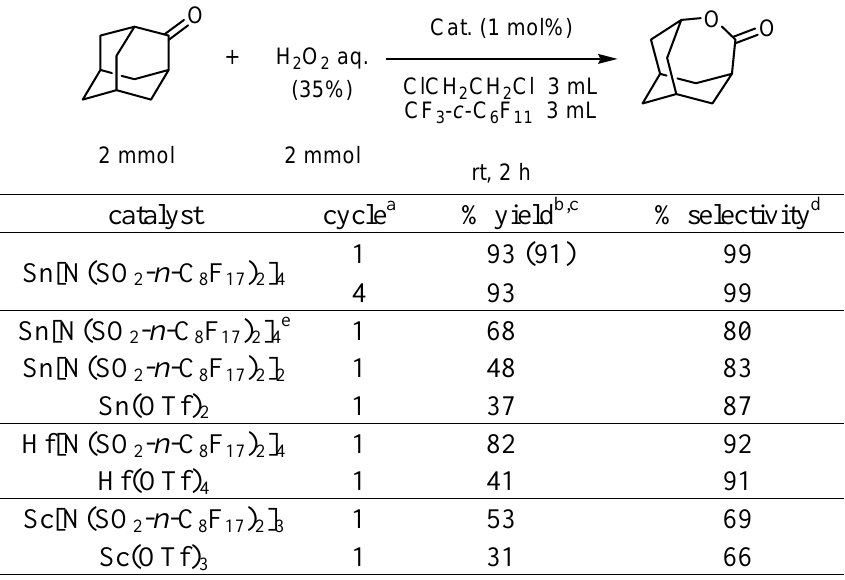
Table 4. Baeyer − Villiger reactions with aqueous H